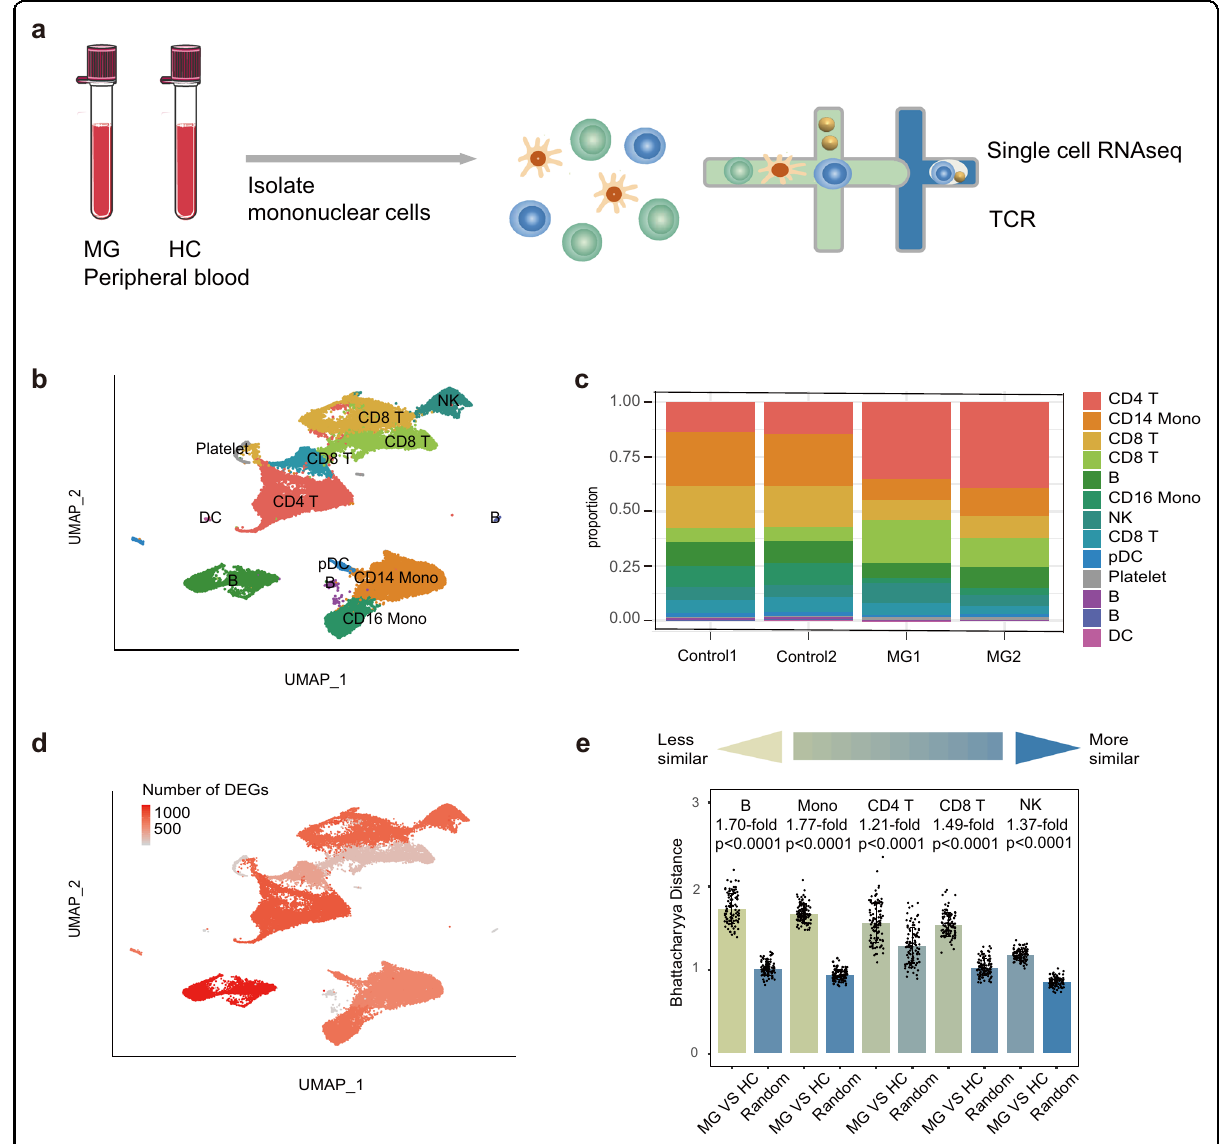
Fig. 1 Assessment of major changes in transcriptional pro fi les between MG patients and healthy controls. a Overview of the scRNA-seq experiment: PBMCs were isolated from two healthy controls and two myasthenia gravis patients. Overall, ~39,243 cells were included in the functional analysis. b Uniform manifold approximation and projection (UMAP) representation of scRNA-seq data showing the seven main cell types: CD8 + T cells, CD4 + T cells, B cells, CD14 + monocytes, FCGR3A + monocytes, NK cells, and DCs. c Cluster abundance across all samples. d Number of DEGs between MG and HC cells within each cluster projected onto the UMAP. DEG: |log fold change| > 0.5; P- value < 0.05 was calculated using DESeq2. e Quanti fi cation of differences between major immune cells between MG patients and HCs. Each dot represents a sub-sample of 500 cells from the principal component analysis space for MG patients and HCs. For the random groups, we sampled 500 cells of sample type. The height of the bar represents the mean values of the subsamples. All comparisons were signi fi cant due to 100 replicates of testing, while the mean fold change varied from 1.77-fold (monocytes) to 1.21-fold (CD4 + T cells). P values are from a Wilcoxon rank-sum test comparing the MG vs HC groups to the random selection for each type of major immune